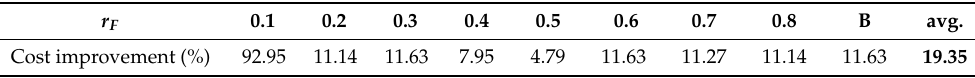
Table 5. Comparison of improvement in each cost compared with the one when r F is